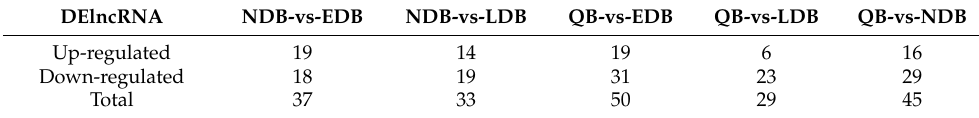
Table 1. The number of DElncRNAs identified by intergroup